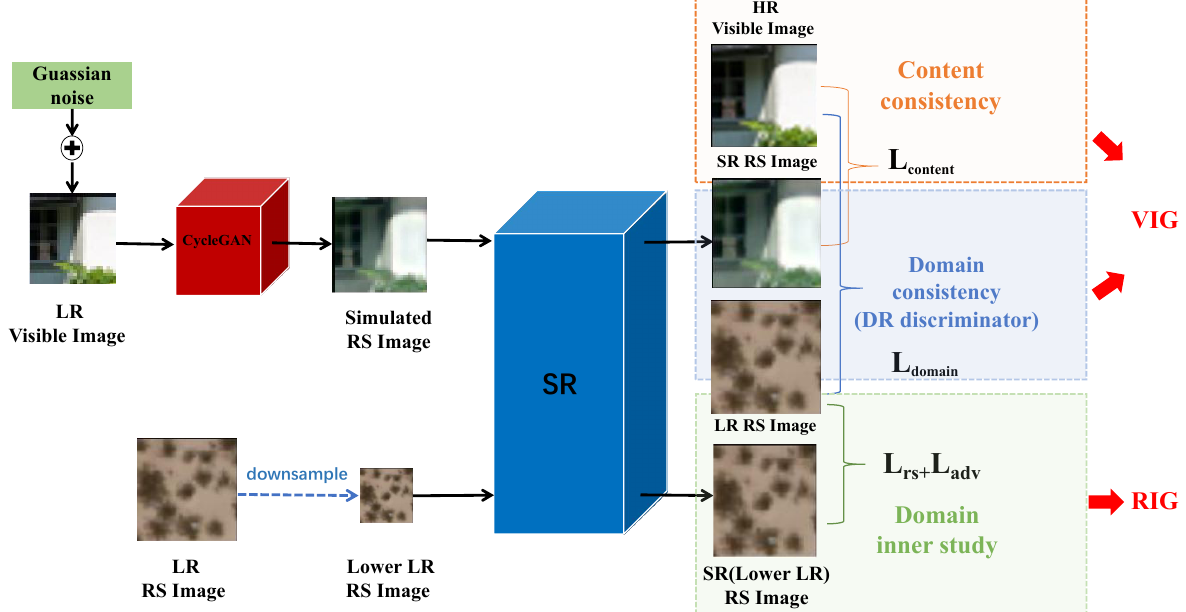
Figure 1. The architecture of the proposed UVRSR.The proposed network consists of two learnable training branches: VIG and RIG. VIG learns the detailed texture and high-frequency information in the reconstruction by the HR visible images. In RIG, the remote sensing image inner relationship is learned by LR remote sensing